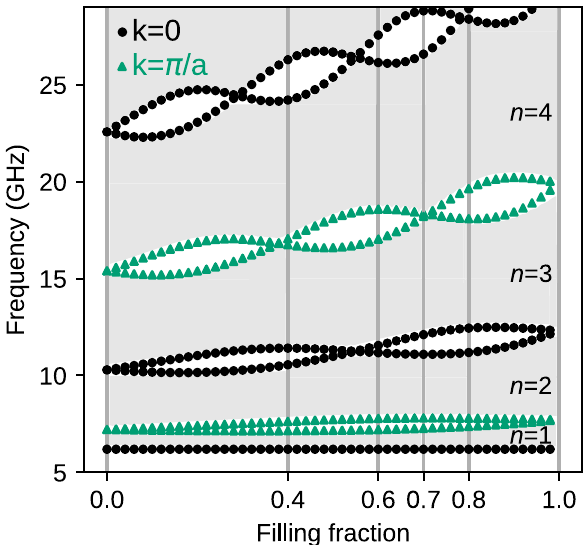
Figure 2. The evolution of SW spectra in dependence of the bulk parameter: filling fraction ff for exchange 100 nm). White areas represents frequency gaps, while gray regions correspond to the dominated 1D MC ( a = 0 and k 1, 2, 3 . . . . The edges of the bands: k π/ a are marked by black dots successive frequency bands: n = = = 0.4, 0.7 and ff 0.6, 0.8 denote the pairs which were and green triangles, respectively. The vertical lines at ff = = interfaced to look for the SW interface modes in common frequency